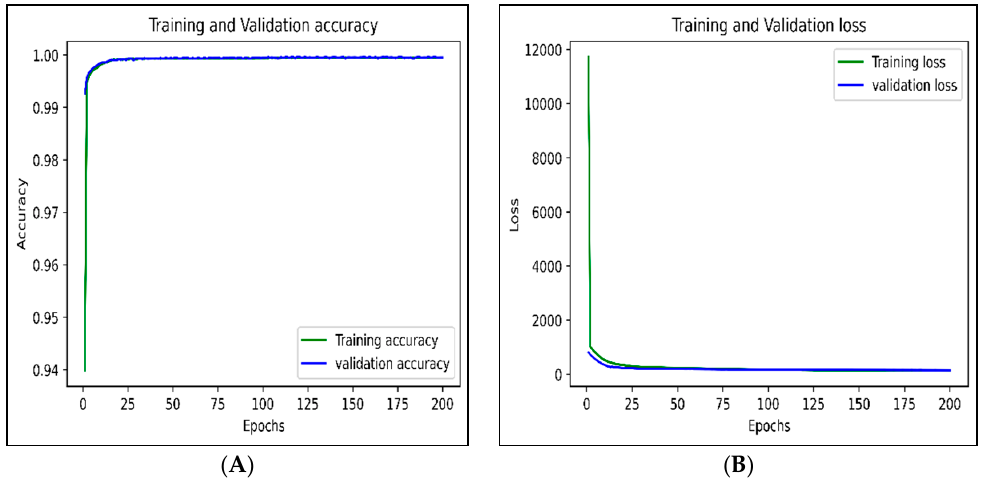
Figure 17. ( A,B ): Accuracy and Loss curves for Thursday morning sub-dataset.